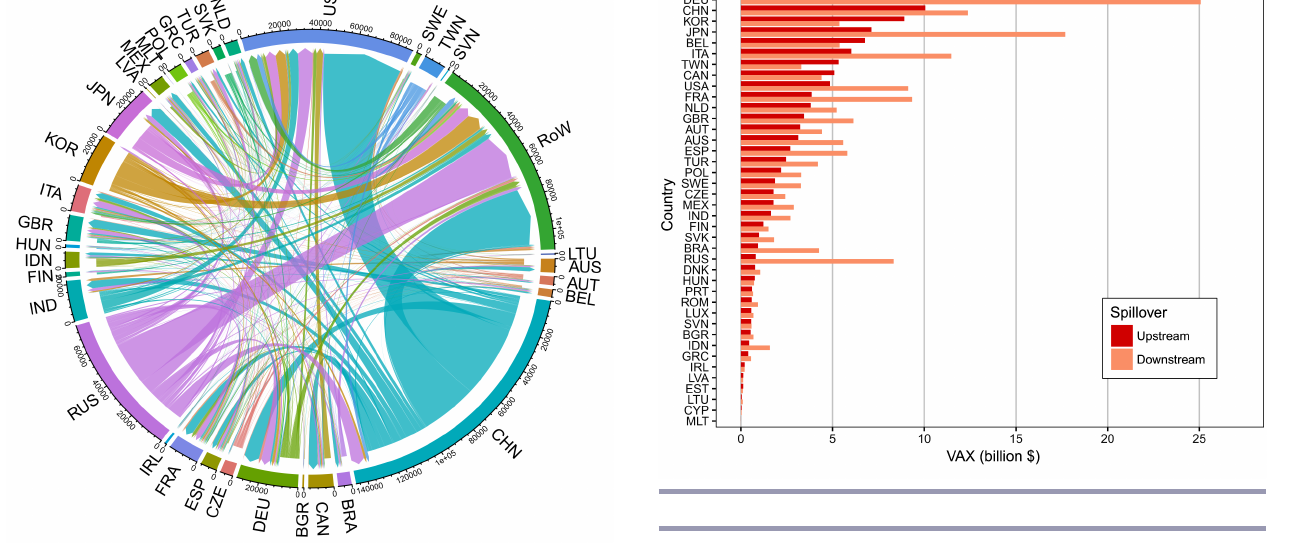
Fig. 6 . Upstream and downstream spillovers of embedded greenhouse gas (GHG) emissions by country. Countries are sorted from top to bottom by upstream spillover. Country codes are specified in Table